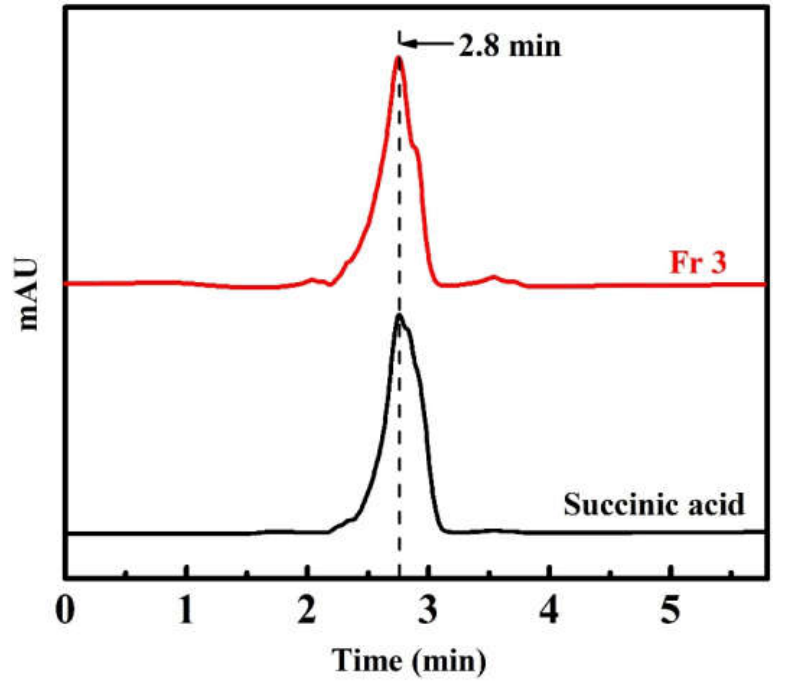
Figure 5. HPLC chromatogram of the Fr 3 and succinic acid